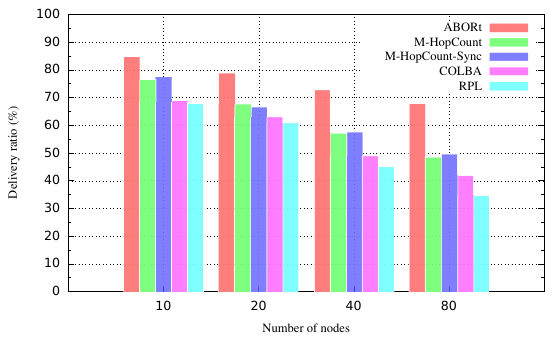
Figure 4. Packet delivery ratio for 5 pkts/s/node.